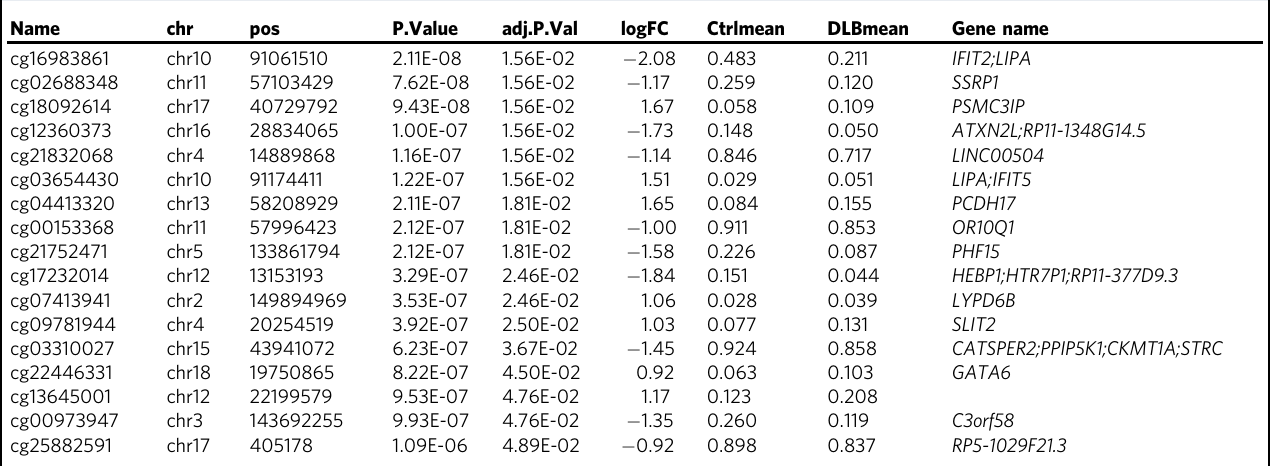
Table 2 The list of differentially-methylated CpGs (DMCs) at q-value <